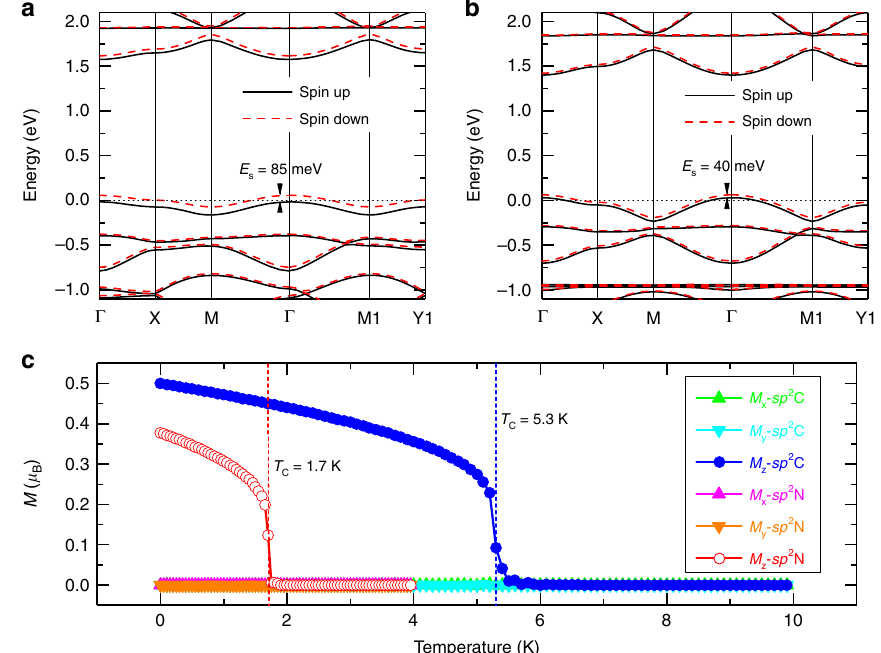
Fig. 4 Ferromagnetism in sp 2 C-COF and sp 2 N-COF. DFT-calculated spin-polarized band structures of monolayer ( a ) sp 2 C-COF and ( b ) sp 2 N-COF with n = 0.5 holes per u.c. DFT-calculated exchange energy splitting ( E h average magnetization per site as a function of temperature for monolayer sp 2 C-COF and sp 2 N-COF by Monto Carlo simulations. The transition temperatures ( T c ) are marked with dashed vertical